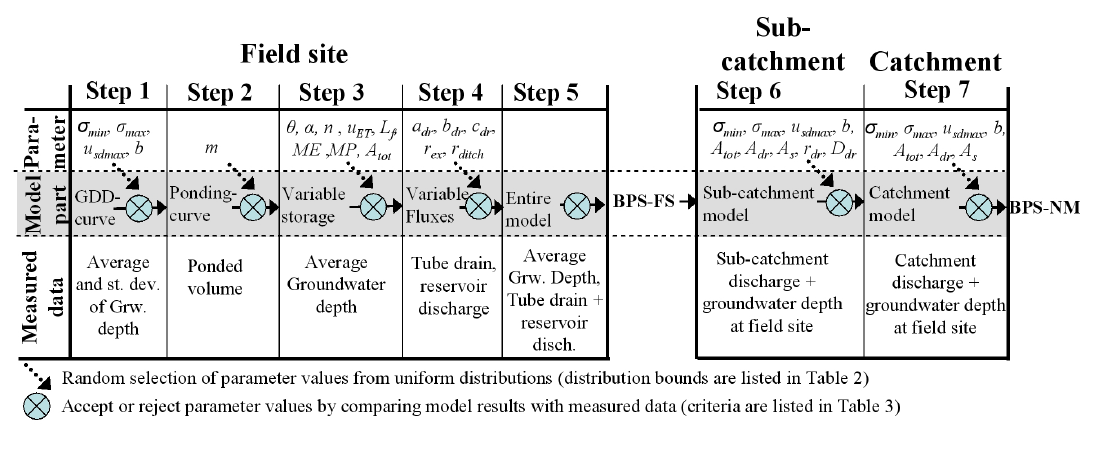
Fig. 2. Procedure for derivation of behavioral parameter sets for the fields-site and the nested-scales model. The first five steps yield behavioral parameter set for the field site (BPS-FS). All seven steps yield behavioral parameter sets for the nested scale model setup (BPS- N). The parameters are explained in Table